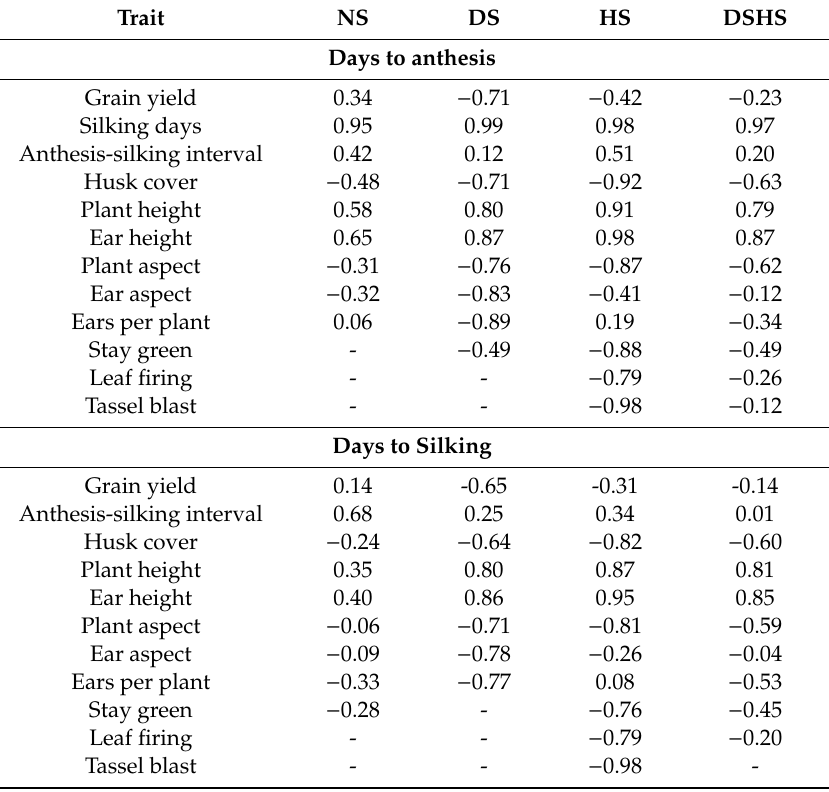
Table 4. Genetic correlation between phenology (days to anthesis and silking) and other secondary traits of 72 extra-early maize accessions evaluated under contrasting environments between 2017 and 2019 in